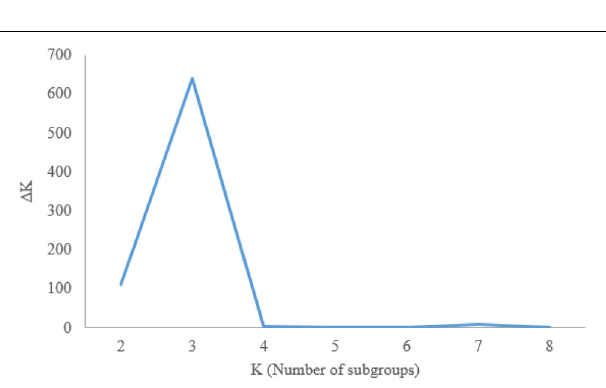
FIGURE 4 | (cid:49) K values calculated for K = 1 to 8 to determine the number of groups in the Iranian wheat landraces and